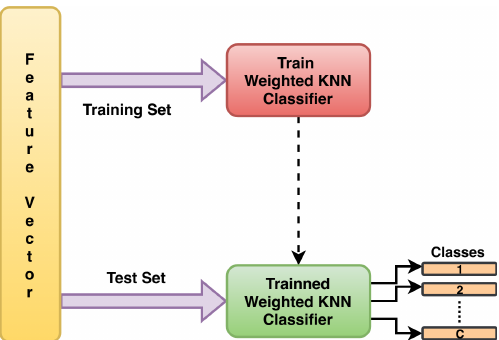
Figure 8. Process of classification of extracted features using weighted k -nearest neighbour ( k -NN)